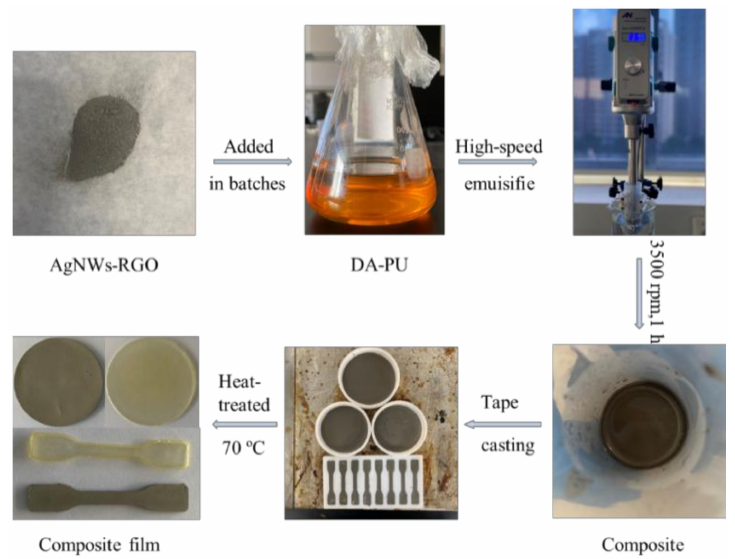
Figure 1. Schematic diagram of the fabrication process of AgNWs-RGO-DA-PU composite